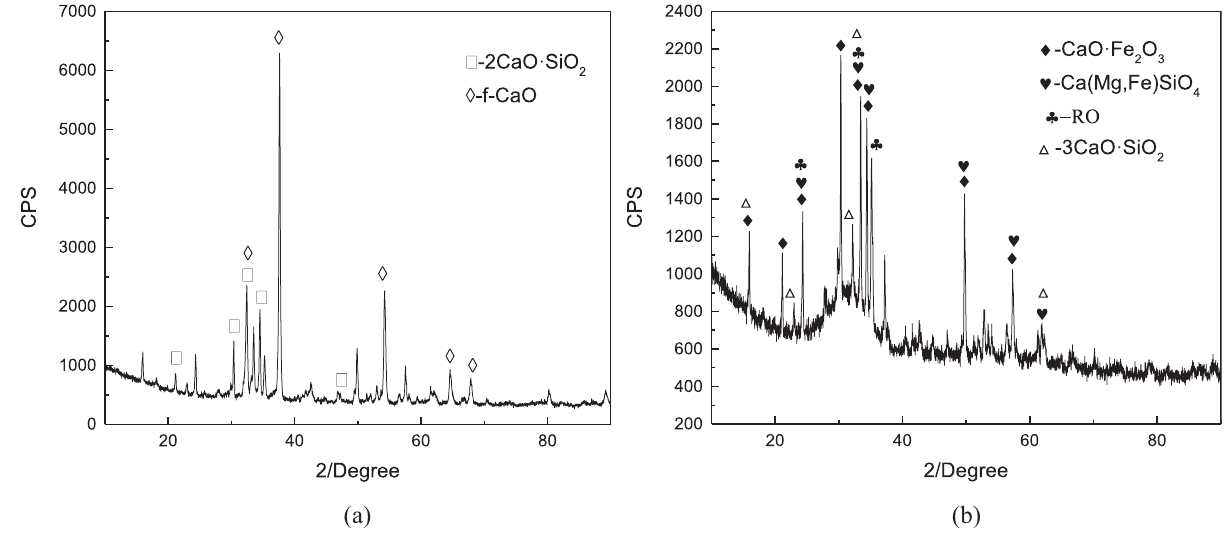
Figure 12: The results of XRD detection for converter slag samples. ( a ) XRD results 1, ( b ) XRD results